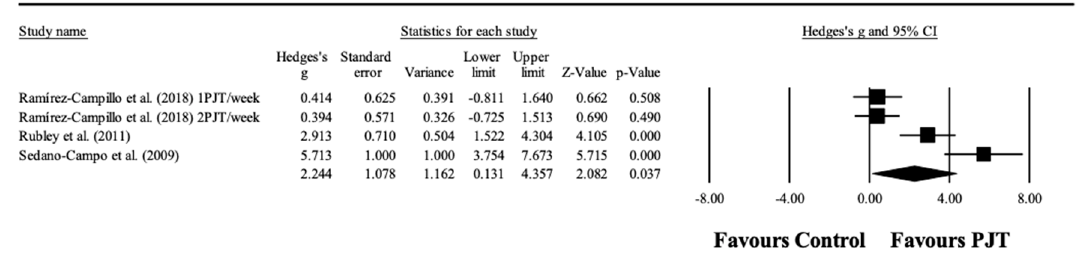
Figure 3. Forest plot of changes in kicking performance, in athletes participating in plyometric jump training (PJT) compared to controls. Values shown are effect sizes (Hedges’s g) with 95% confidence intervals (CI). The size of the plotted squares reflects the statistical weight of the study.